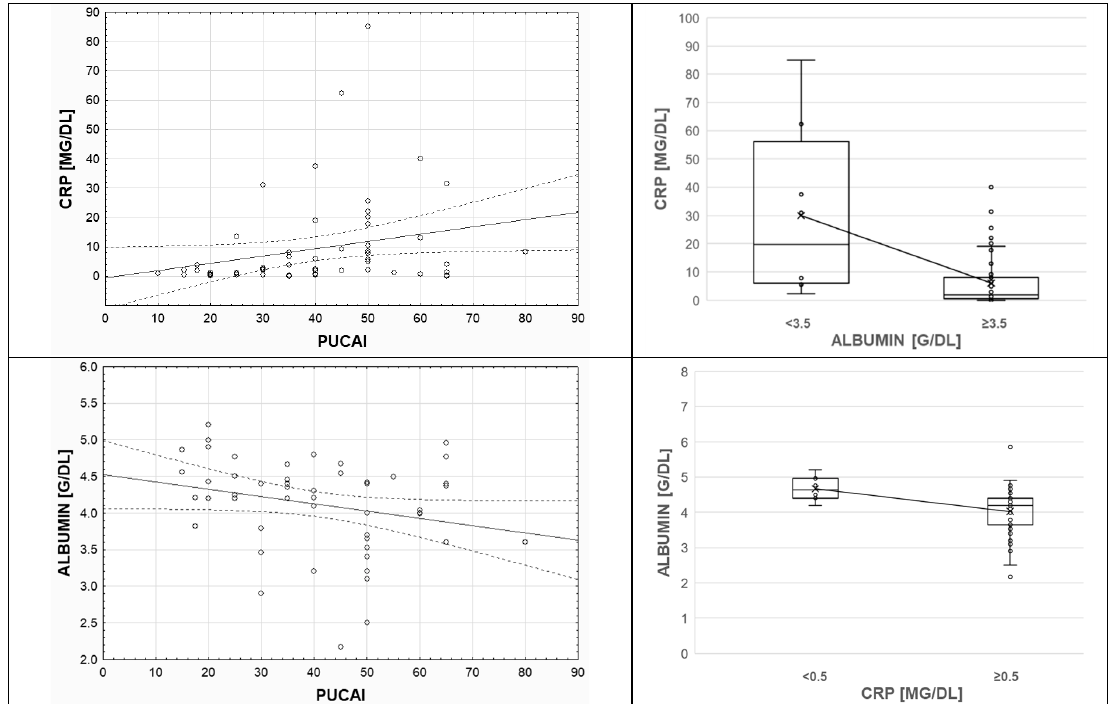
Figure 3. Inflammatory markers’ associations with Pediatric Ulcerative Colitis Activity Index (PUCAI) scores and pairwise associations. Colonic inflammation was associated with higher C-reactive protein (CRP) and lower albumin levels in children with UC. Serum albumin tended to decrease as the values of CRP increased ( p < 0.05). The “x” mark indicates the mean value. The horizontal line within the box plot shows the median.